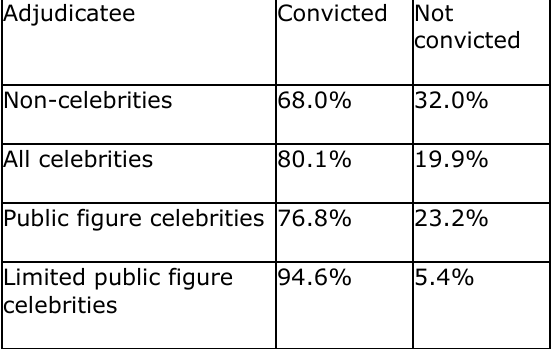
Table 1: Percentage of Convictions for Celebrities